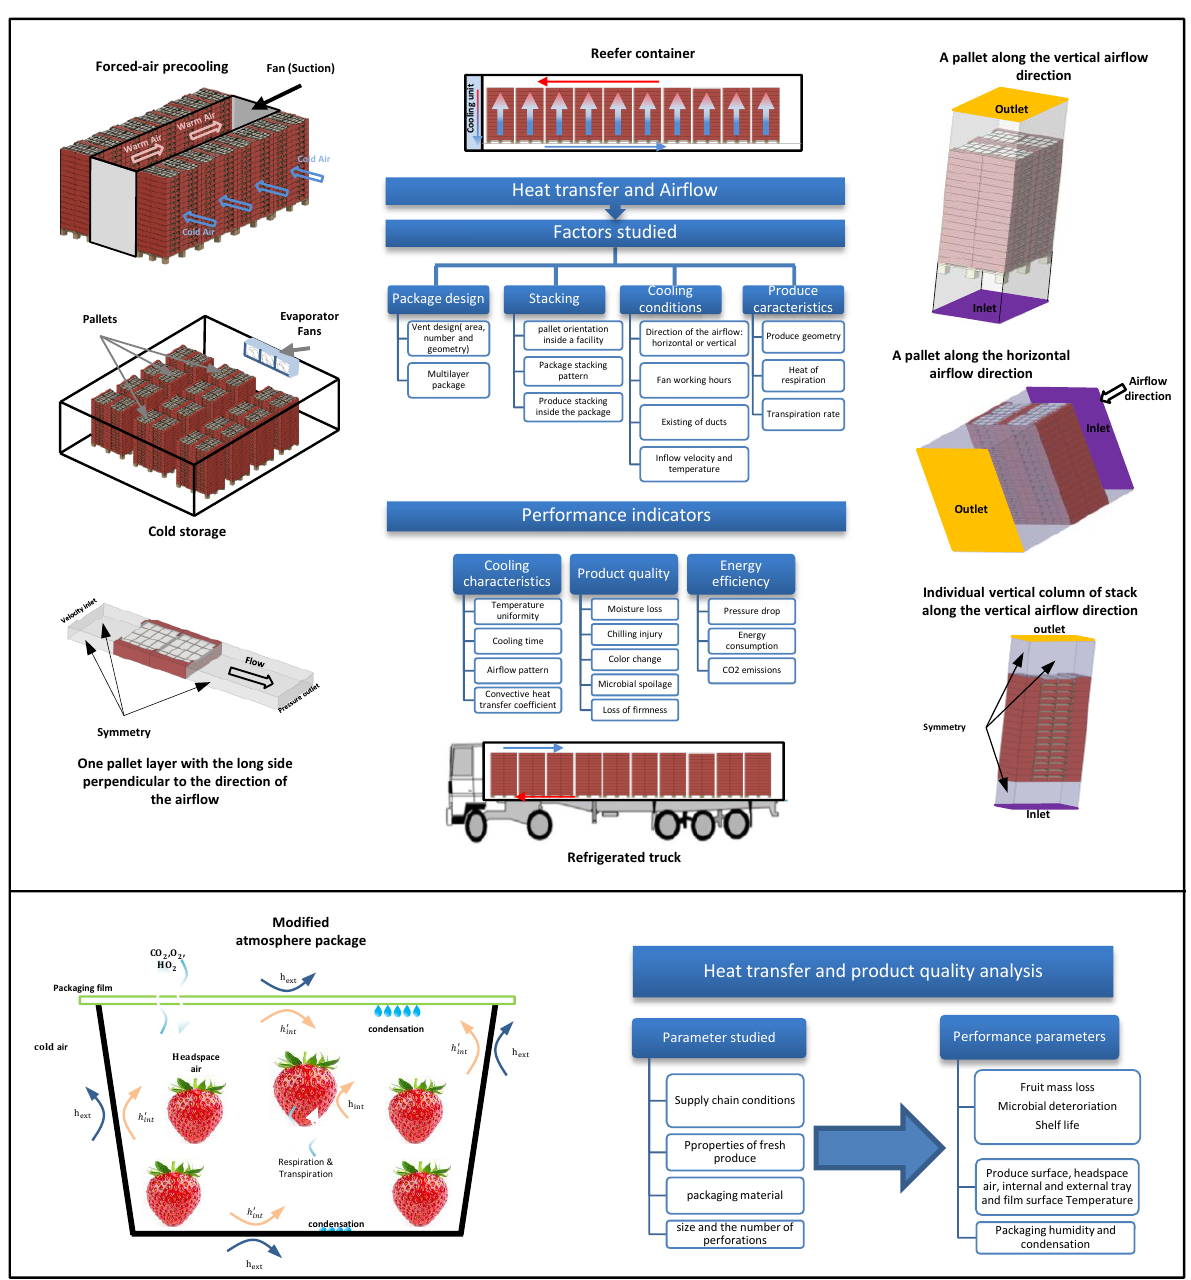
Figure 3. Different scales of model used in heat transfer and airflow studies .